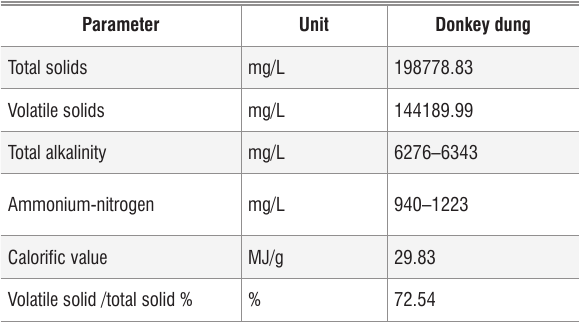
Substrate characteristics for donkey dung